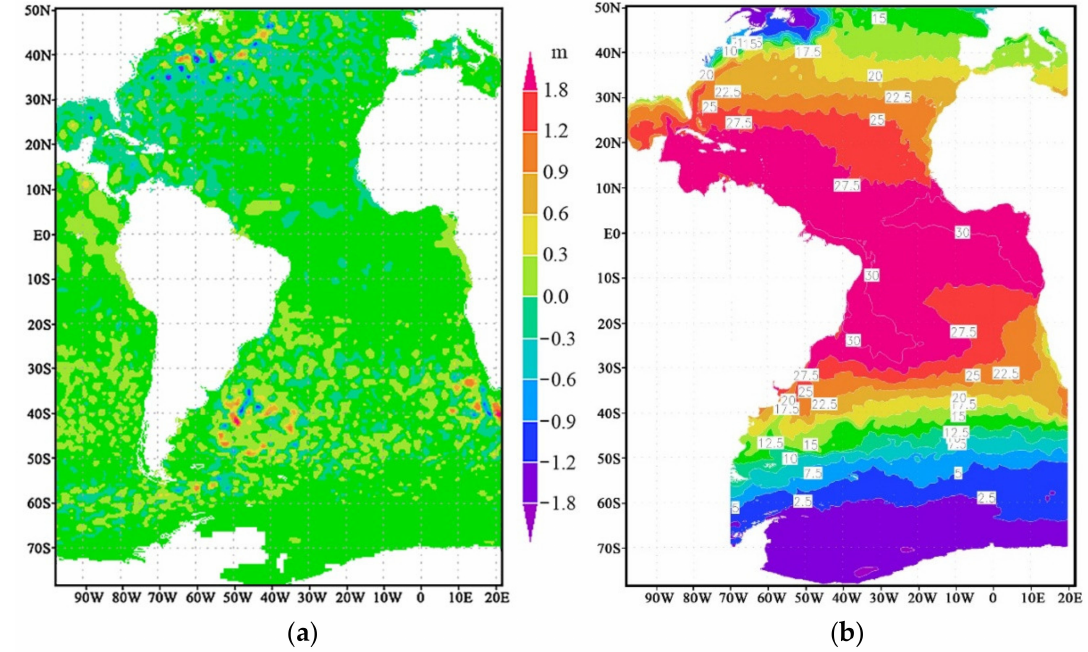
Figure 7. Observed fields: ( a ) SLA; ( b ) SST ( ◦ C) on 27 January